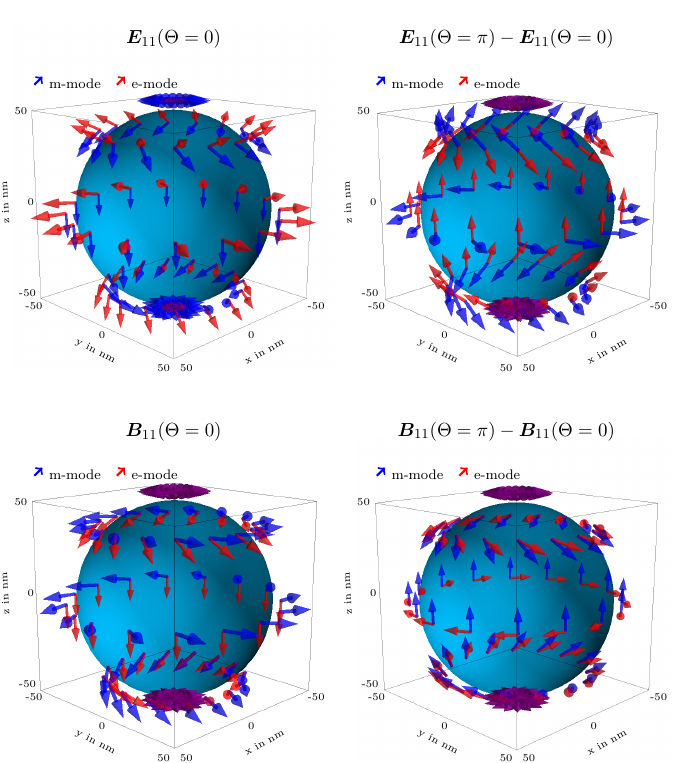
Figure 2: 3D vector representation (based on Eq. (17)) at r = 55nm of the l = 1, m = 1 electric and magnetic modes (absolute value) for the topologically trivial sphere ( R = 50nm, ε = − 1) embedded in vacuum at ħ h ω = 2eV (left hand side) and their modifications due to the axion term (right hand side). Note, that the corresponding magnetic field can be directly derived from the electric field using the third Maxwell equation (Eq.